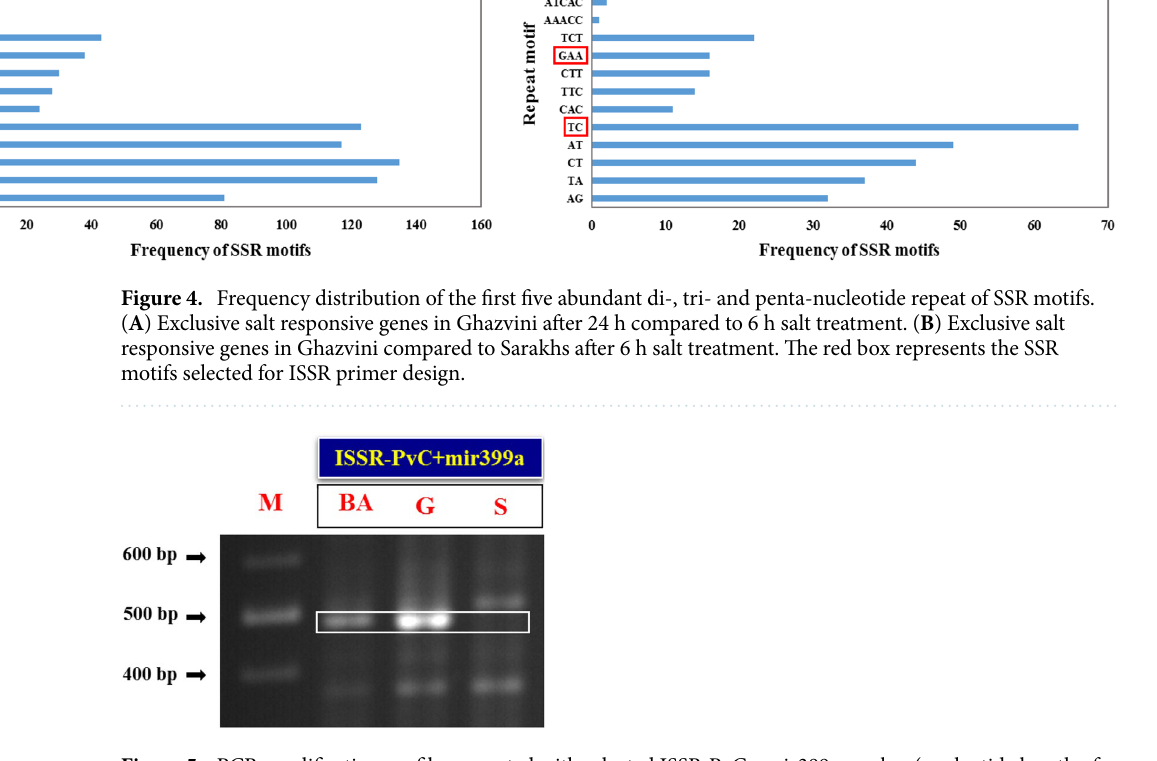
Figure 5. PCR amplification profile generated with selected ISSR-PvC + mir399a marker (nucleotide length of around 490 bp) in the three extreme pistachio populations. Lanes: M: GeneRuler 100 bp Plus DNA Ladder; BA: Badami-Zarand, G: Ghazvini and S: Sarakhs. Full-length gel is presented in Supplementary Figure